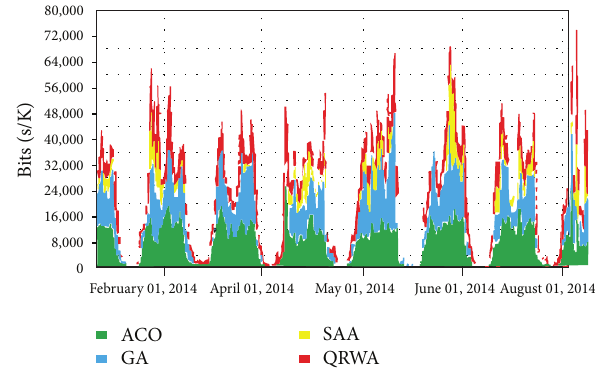
Figure6:ThethroughputofIBMSystemp5520QinACO,GA,SAA, and QRWA during one